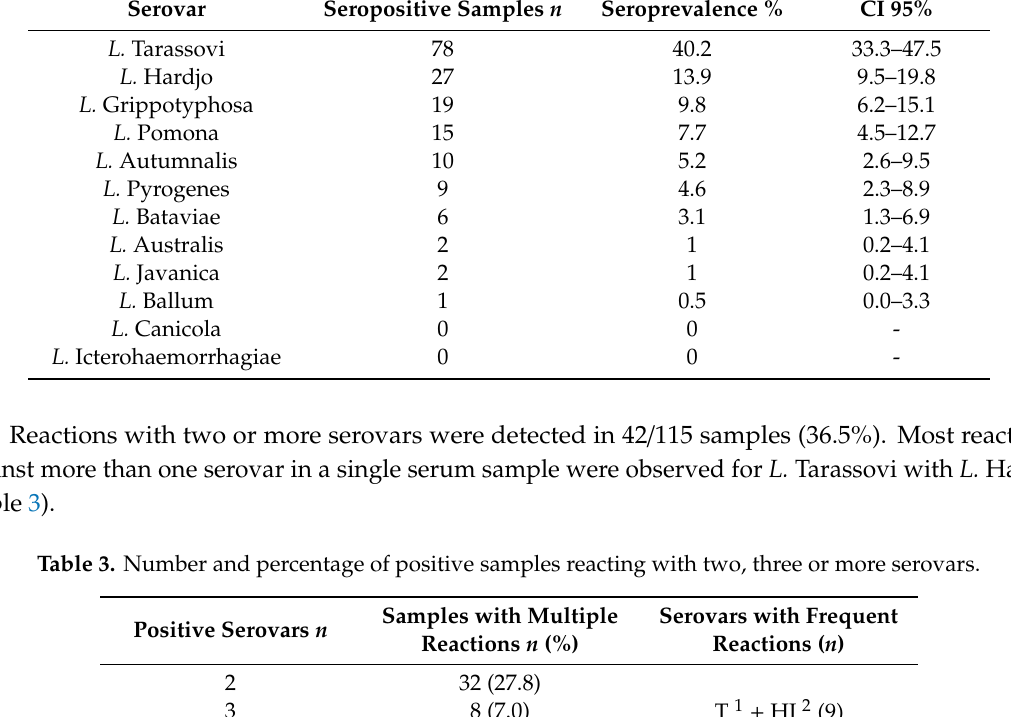
serovar L. Grippotyphosa (Figure 2, Table S2). The geometric mean titer ranged from 1:100 ( L. Ballum) to 1:247 ( L. Grippotyphosa) (Figure